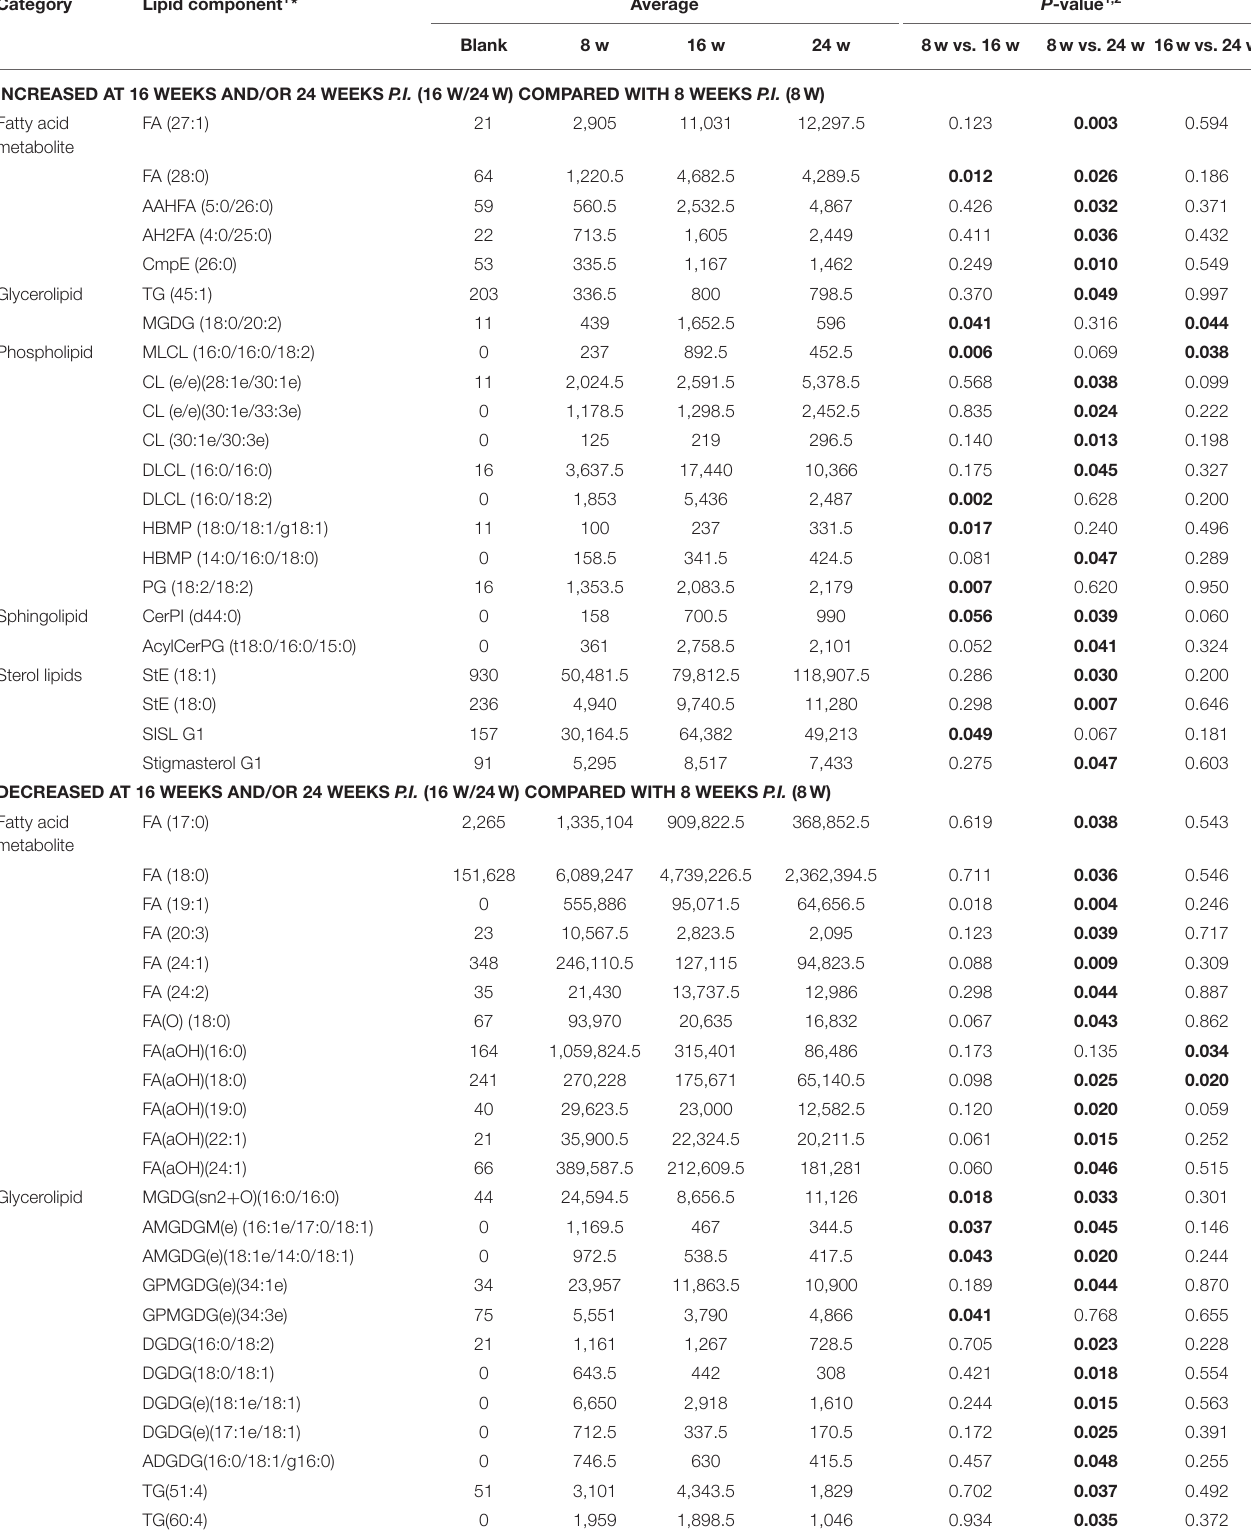
TABLE 2 | Summary of altered lipids in the gut of laying hens between 8, 16, and 24 weeks p.i . Category Lipid component 1 *